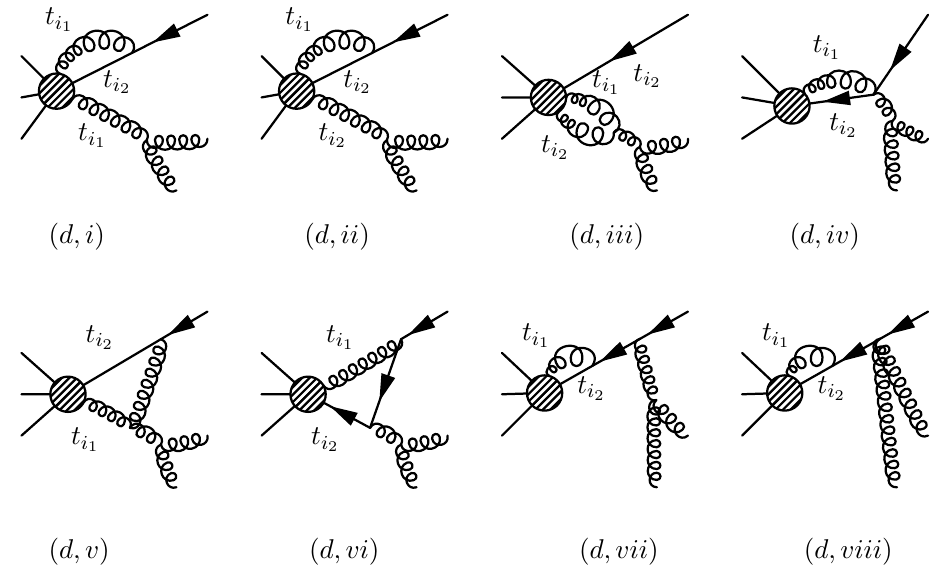
Figure 12 . 1PR diagrams contributing to the mixing J B 2 in the collinear sector with fermion number F i =